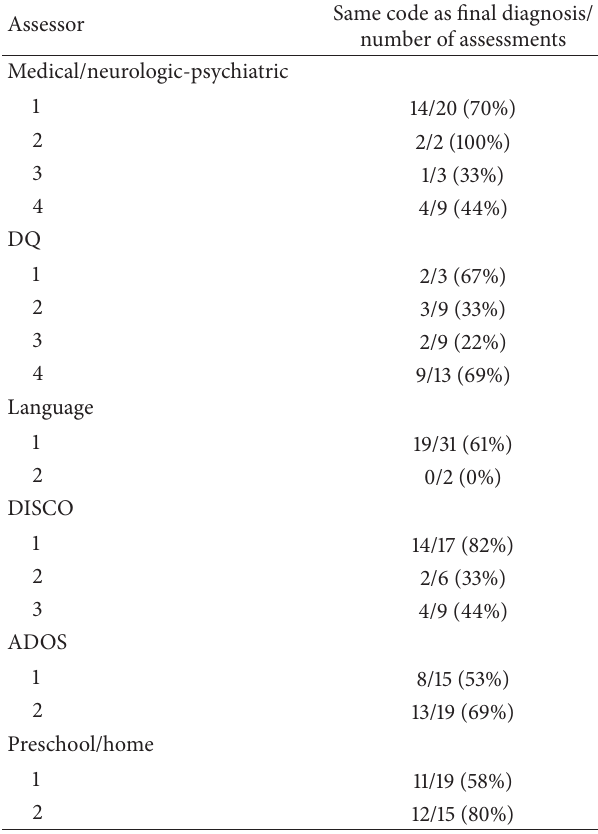
Table 2: Individual assessor’s agreement with final diagnosis.